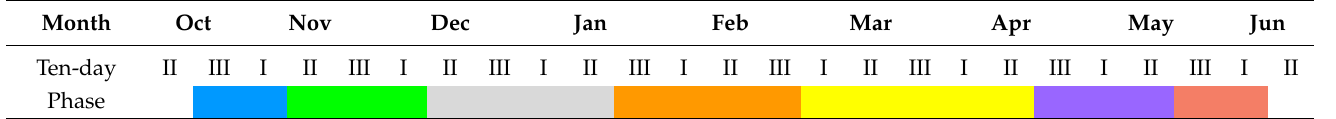
Table 1. Phenological calendar of rapeseed in Jiangsu Province.